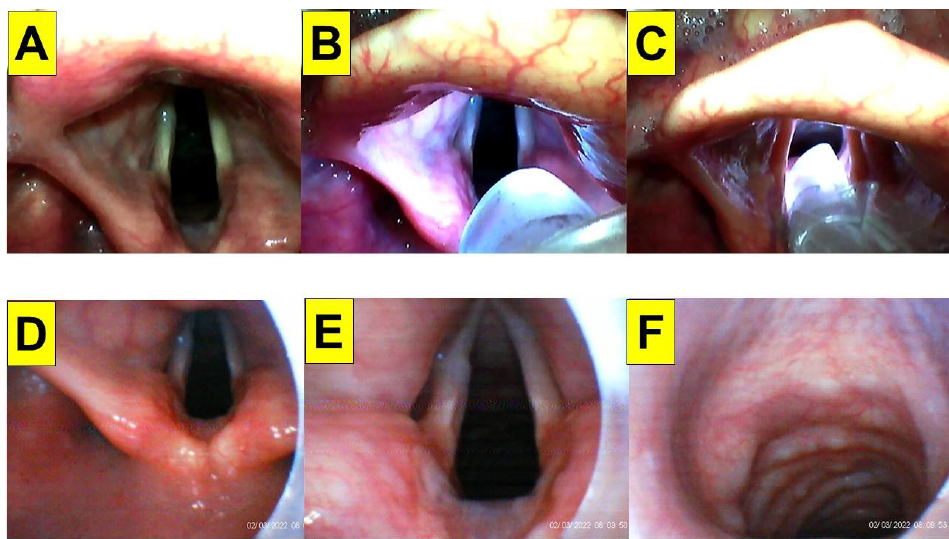
Figure 3. Application of video-twins technique in a patient underwent an elective surgery. A 64-year-old man with a BMI 25.0 kg/m 2 . Mallampati class III and Cormack-Lehane laryngoscopic view grade